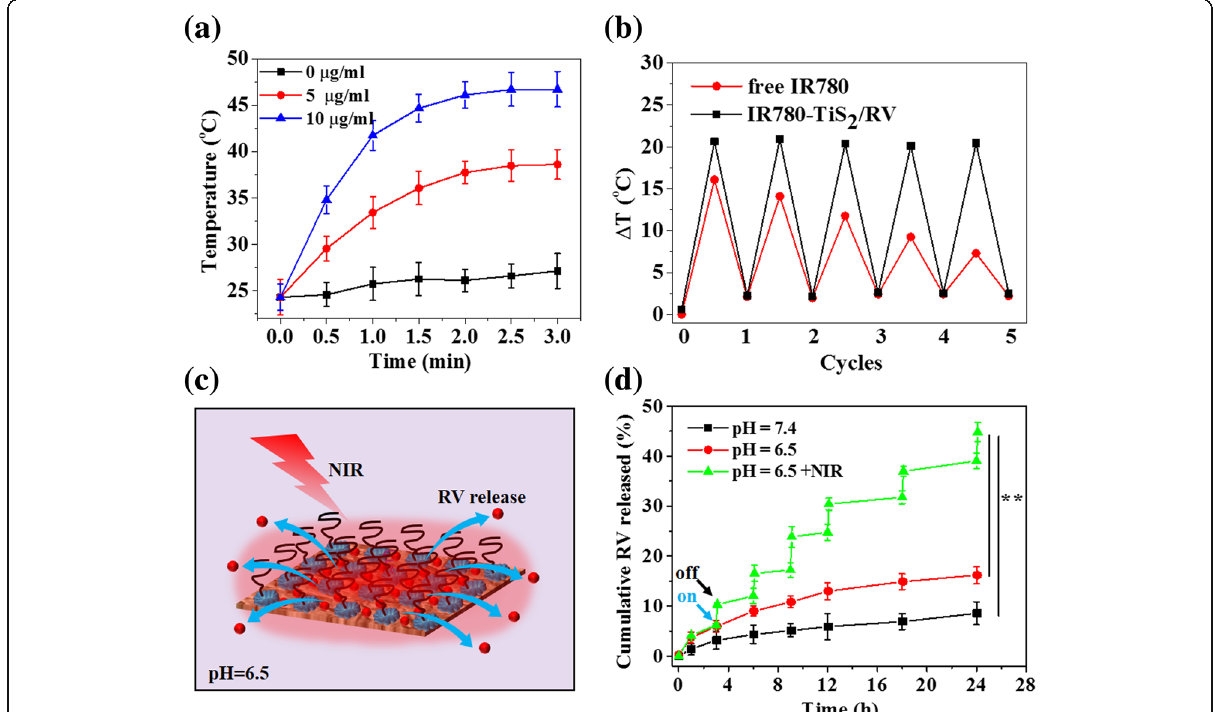
Fig. 2 a The photothermal effect of IR780-TiS 2 /RV under the NIR irradiation (808nm, 0.3W/cm 2 ) for 3 min. b Temperature change of IR780 and R780-TiS 2 / RV after five cycles of NIR irradiations (808nm, 0.3W/cm 2 , 3min). c The schematic of photothermal-triggered RV release. d Release kinetics of RV from IR780-TiS 2 /RV in PBS buffer (pH=7.4 and 6.5) with or without NIR irradiation (808nm, 0.3W/cm 2 ). **P <0.01, compared with pH=7.4 and pH=6.5